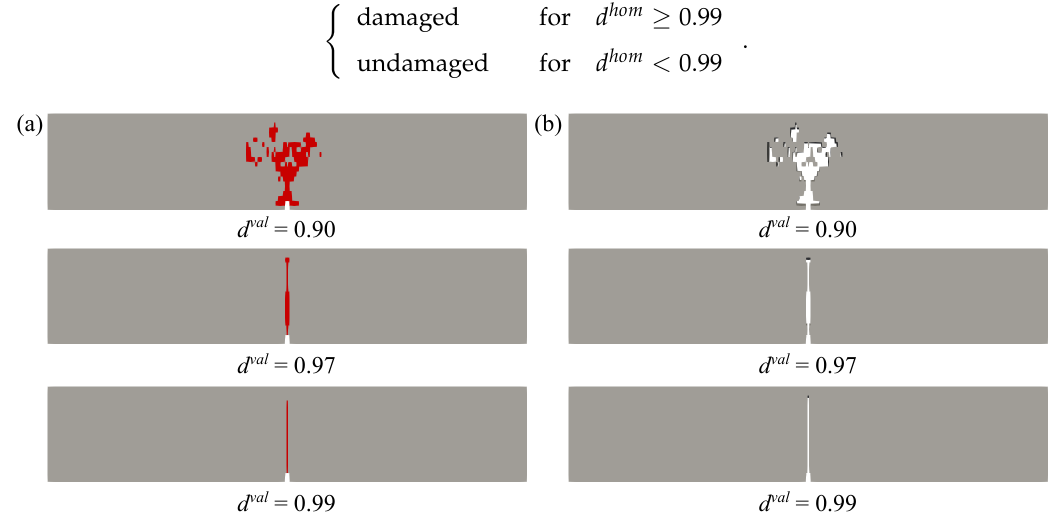
Figure 5. Four-point bending test using three different d val implementing an adaptive element erosion: ( a ) crack paths and ( b ) removed